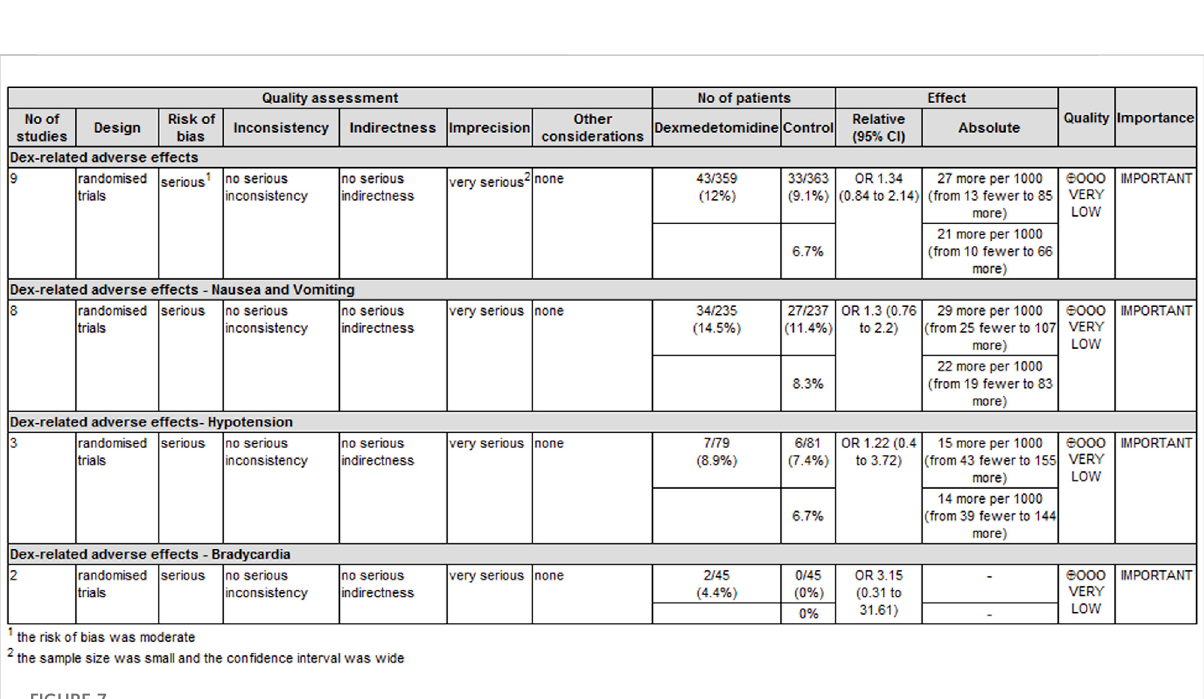
FIGURE 7 GRADE rating for evidence of adverse effects. Abbreviations: OR, odds